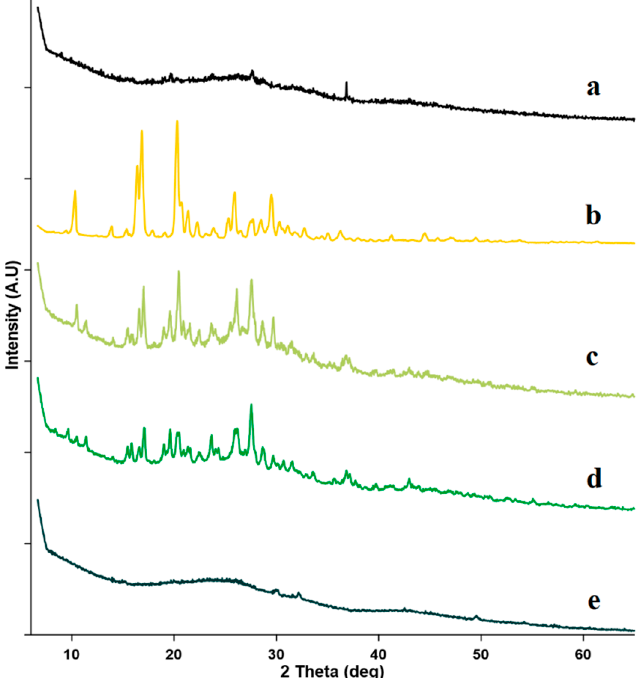
Figure 5. PXRD for: ( a ) Sulfonatocalix[4]naphthalene, ( b ) fluconazole (FZ) ( c ). Physical mixture (PM) ( d ). Kneaded (KN) and ( e ) co-evaporate powder (CO).